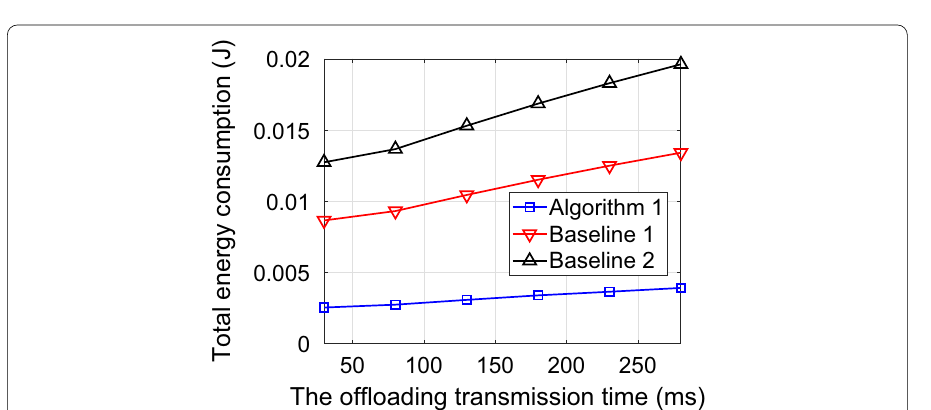
Fig. 4 The total energy consumption v.s. the offloading transmission time, τ